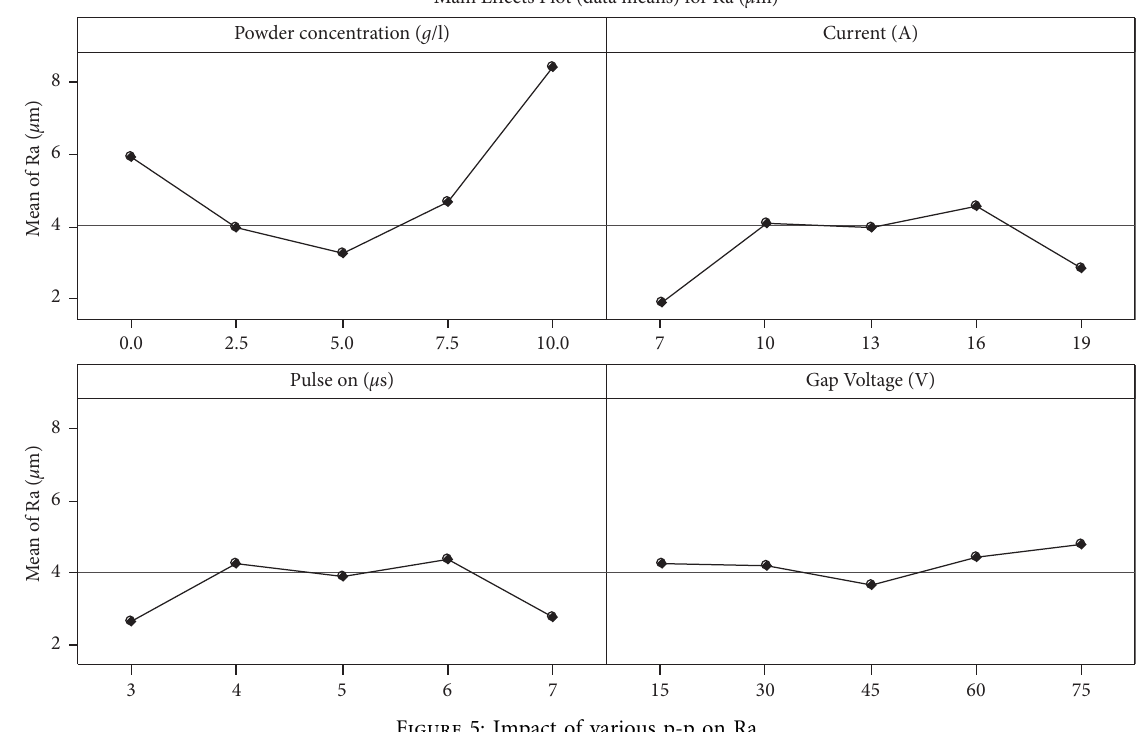
Figure 5: Impact of various p-p on Ra.